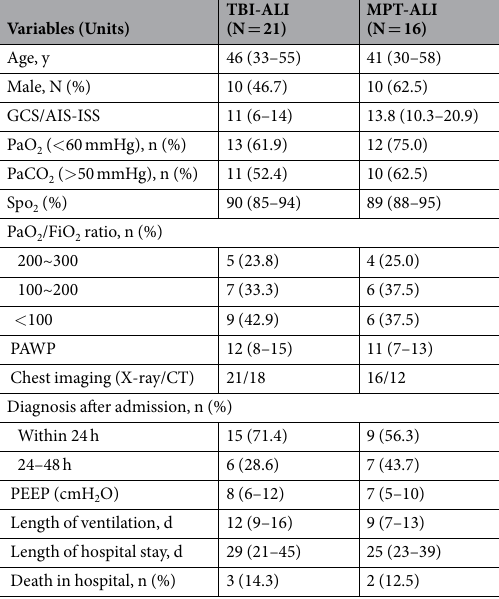
Table 2. Clinical Characteristics of Patients with ALI (N = 37). Data are presented as numbers (%) or medians (interquartile range). AIS-ISS, Abbreviated Injury Scale-Injury Severity Score; ALI, acute lung injury; GCS, Glasgow Coma Scale; MPT, multiple peripheral trauma; PAWP, pulmonary artery wedge pressure; PEEP, positive end-expiratory pressure; TBI, traumatic brain